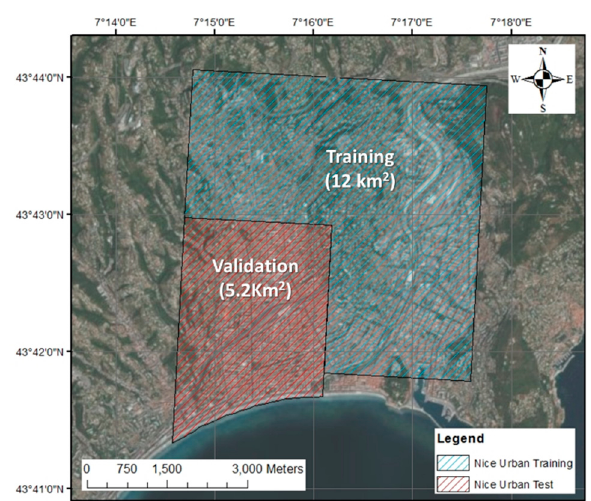
Figure 4. Training and validation areas in Nice: dense urban areas.